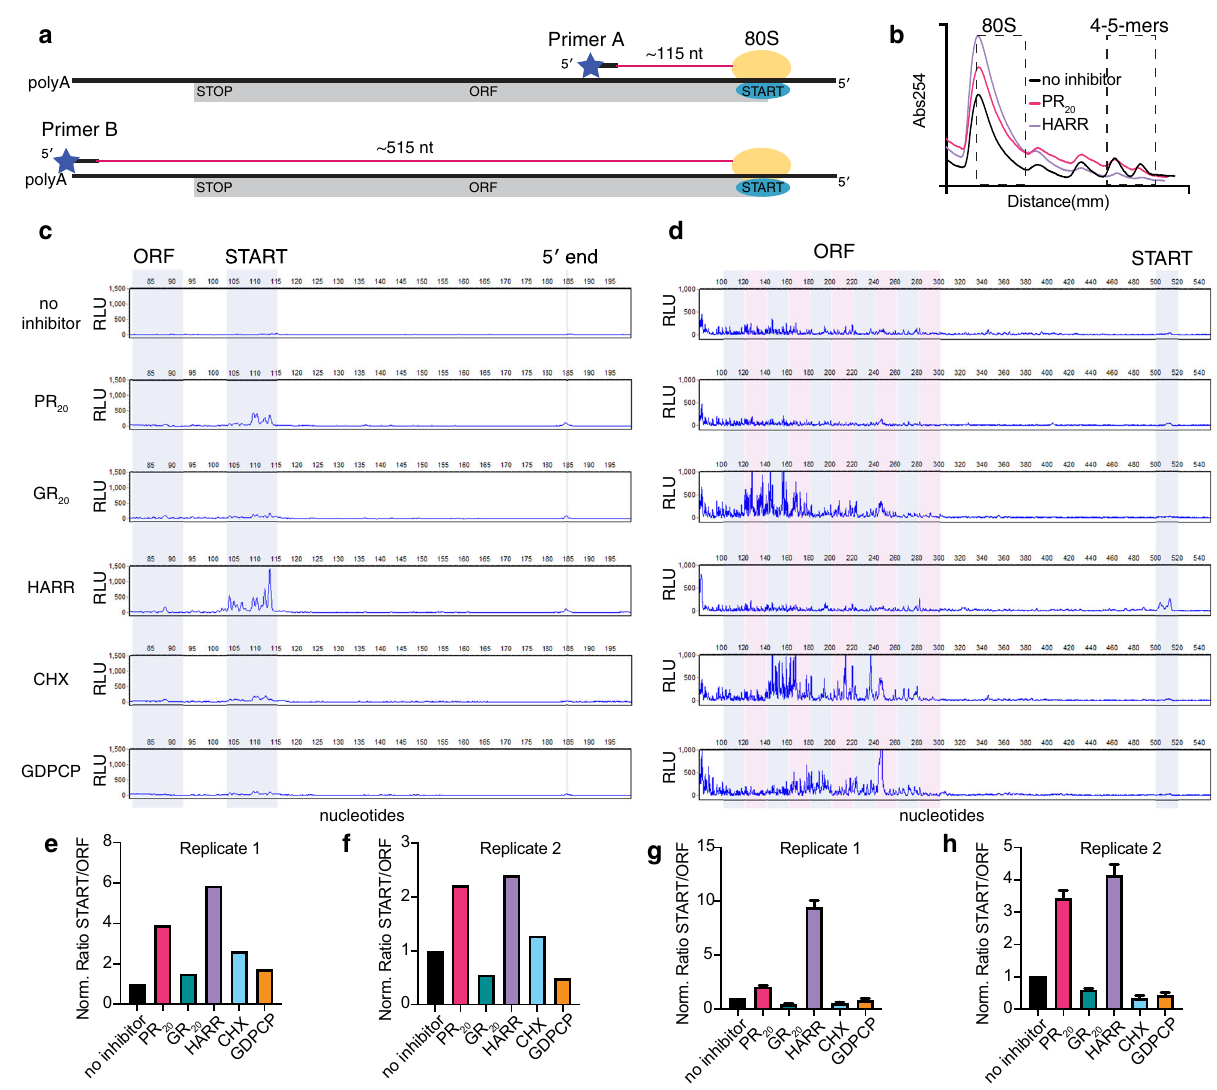
Fig. 2 Toeprinting analyses identify ribosome stalling sites with PR 20 and GR 20 . a Scheme of toeprinting experiments using two fl uorescently-labeled primers, primer A and primer B. Primer extension through the open reading frame (ORF) to ribosomes stalled at the start codon is expected to yield a peak at ~115 nt for Primer A or at ~515 nt for Primer B. b Following a 5-min translation reaction at 37 °C in the absence or presence of inhibitors (no inhibitor, 4 μ M PR 20 , 4 μ M GR 20 , 40 μ M harringtonine, 100 μ g/ml cycloheximide or 100 μ M GDPCP), sucrose-gradient fractionation was used to separate free mRNA from various ribosome fractions. The 80S fraction and 4 – 5-mer fractions (dashed boxes) were used in assays shown in panels b , c . The sucrose gradient traces are shown for no inhibitor, PR 20 and harringtonine. c The 80S fraction was subjected to toeprinting analysis with primer A via fragment analyzer (see Methods). Traces reveal peaks at the expected location of the start codon. The blue-shaded zones of the traces were quanti fi ed for panel e , indicating enrichment of ribosomes stalled at the start codon relative to a region of the ORF especially in samples treated with harringtonine and PR 20 . d As in ( c ) except that the 4-5mer polysome fraction was used for toe-printing analysis with primer B. Traces show many peaks in the ORF of the mRNA and also at the start codon. Blue and pink boxes indicate sections of the trace used in quanti fi cation in panel g . e The normalized ratio of start-codon- associated toeprints to coding-region-associated toeprints in the 80S fraction using primer A. f Independent repeat of toeprinting reaction as in e . g The normalized ratio of start-codon-associated toeprints to coding-region-associated toeprints. Ten different windows (20 bp in length each) within the coding region were quanti fi ed relative to a 20 bp window around the start codon, and the mean ± SEM is shown. h Independent repeat of toeprint reaction as in g . Source data are provided as a Source Data fi Maximum-likelihood classi fi cation of our cryo-EM datasets rabbit 80S (cid:129) tRNA (cid:129) GR 20 map, which is not present in the control revealed that all yeast and mammalian 80S ribosome states 80S (cid:129) tRNA and other complexes analyzed in this work. The contained poly-PR or poly-GR in the polypeptide tunnel and the density at the intersubunit bridge B6 58 near protein eL24 might account for four GR repeats in a subset of 80S particles PTC (Supplementary Figs. 3, 4), in contrast to the negative- (Supplementary Fig. 4q). Alternatively, this density may be part control 80S complex assembled without the DPR proteins of the eL24 C-terminal domain (residues 64 onward), for which (Supplementary Fig. 4a – d). These observations are consistent no unambiguous density could be found in our maps. Either with the high af fi nity of these DPR proteins for the ribosome, direct binding of GR 20 at this location or GR 20 -mediated eL24 implied by the IC50s and puromycin kinetics measured in our conformational change could interfere with intersubunit rotation biochemical experiments. An additional density is present in the